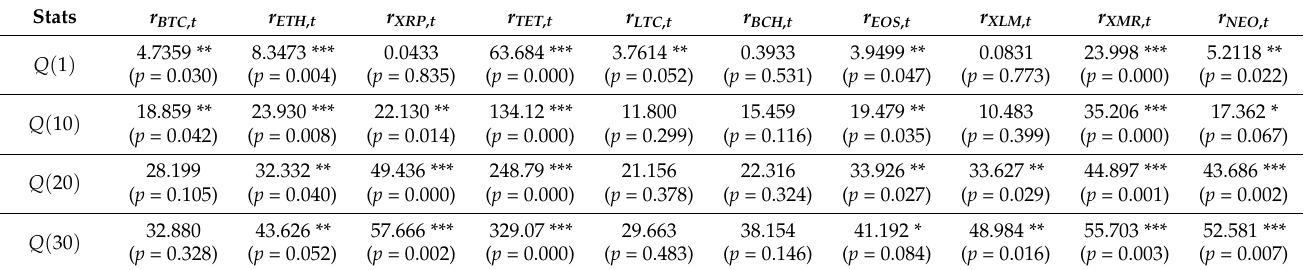
Table 6. Ljung–Box autocorrelation test for the 10 cryptocurrencies’ return indices based on the full